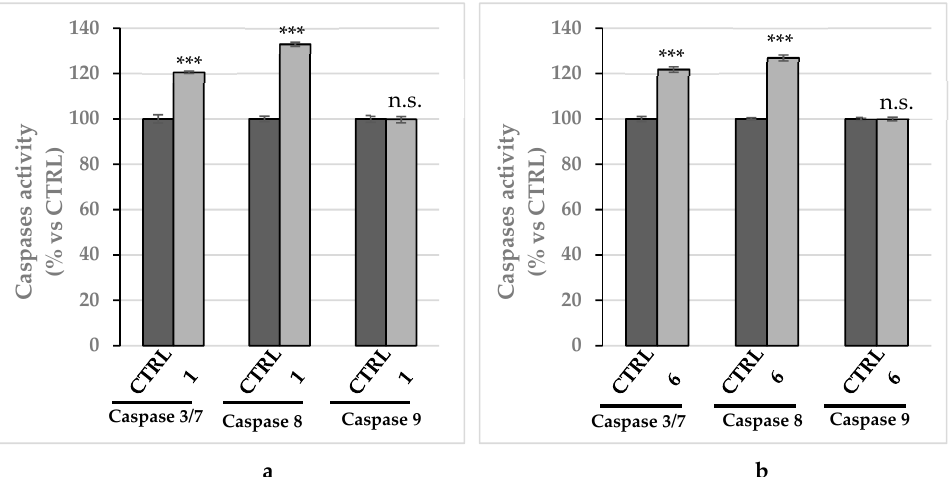
Figure 10. Caspases’ activity. Increase of caspases 3/7 and 8 activity levels, reported as percentage over the vehicle-treated cells used as control, following treatment of MDA-MB-231 cells with compound 1 ( a ) and MCF-7 cells with compound 6 ( b ). Both the compounds were used at their IC 50 values and incubated for 24 h. The data are representative of three independent experiments. *** p < 0.001 and n.s. not significant; treated vs. CTRL.